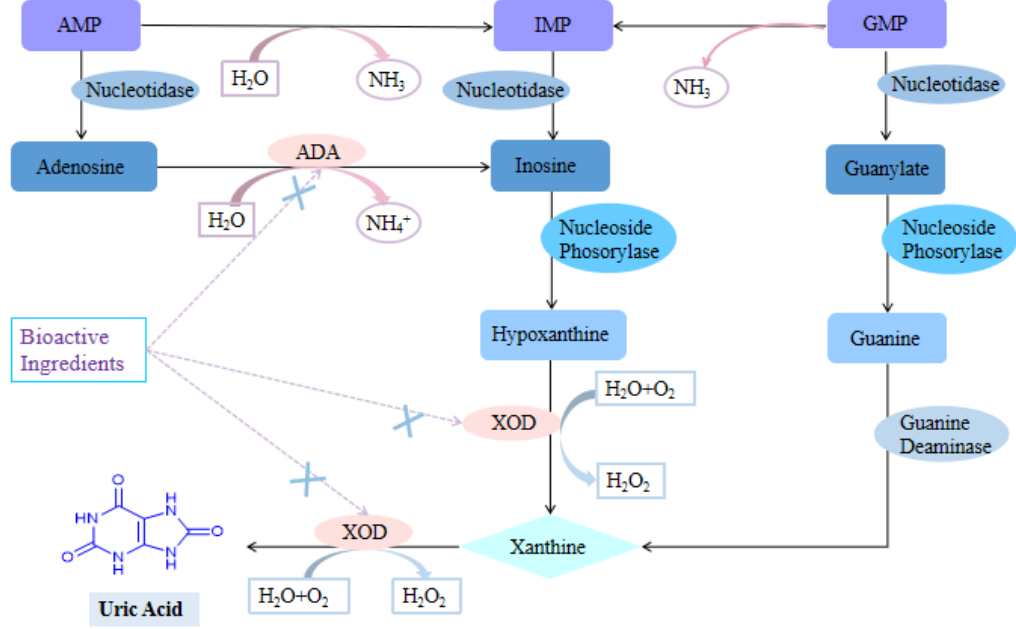
Figure 1. Xanthine oxidase (XOD) and adenosine deaminase (ADA) inhibitory mechanisms of bioactive ingredients.